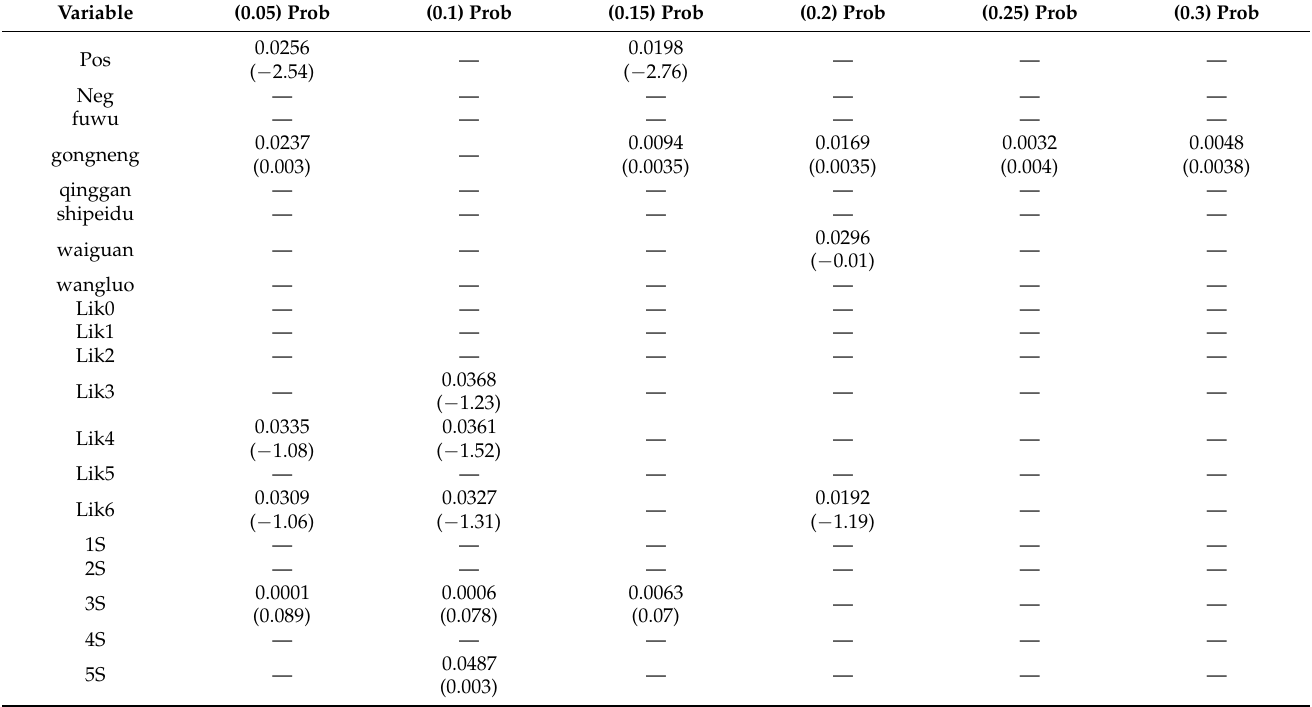
Table 14. Variables significant at 0.05 to 0.3 points.